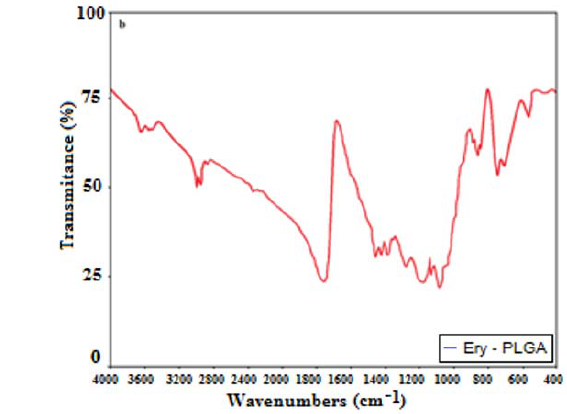
Figure 11. FTIR spectra of Ery ‐ PLA and Ery ‐ PLGA. FTIR data revealed that Ery ‐ PLGA nanoparticles’ peaks at around 3650 cm − 1 and 3500 cm − 1 , attributed to O ‐ H stretching vibrations, at 1760 cm − 1 to C=O stretch, at 1460 cm − 1 assigned to C ‐ H link, at 1400 cm − 1 to N=O binding, 1180 cm − 1 and 1090 cm − 1 to C ‐ N stretch, at 860 cm − 1 and 750 cm − 1 to N ‐ H shiver. Some functional groups were less in number for simple erythromycin, confirming that the drug was not responsible for any interac ‐ tions with the two polymers.